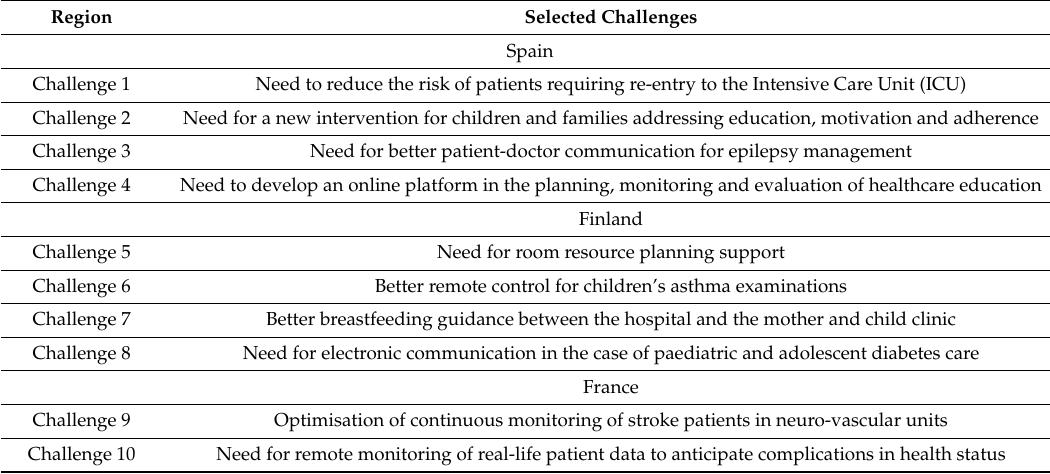
Table 3. Challenges selected for further co-creation (Iteration 1).